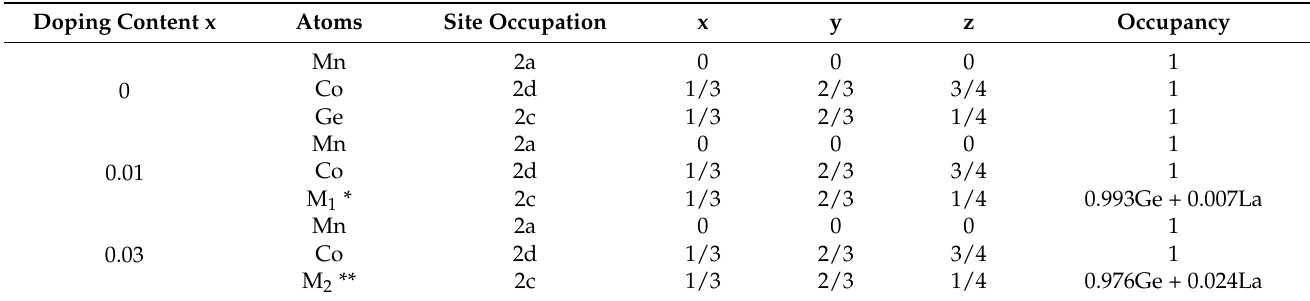
Table 2. Atomic site occupation and occupancy rate of MnCoGe 1 − x La x .